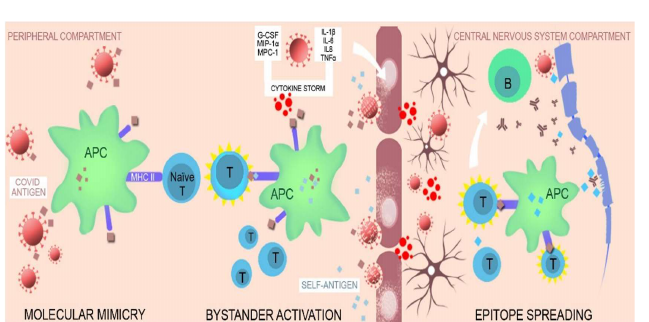
Figure 5. Graphical representation of the proposed mechanisms for viral induced autoimmunity. Key mechanism for viral induced autoimmunity: 1) molecular mimicry -cross-reactive response against virus and self-antigens leading to lymphocyte activation; 2) bystander activation - the released self-antigens are taken by the antigen presenting cells(APC) and presented to naïve T cells which become responsive. Simultaneously, the innate immune system triggers the production of proinflammatory cytokines and chemokines and initiate self-tissue destruction that generate self-tissue antigens mimicking viral antigens; 3) epitope spreading -the viral infection produce futher damage and release of more self-antigens with subsequent activation of auto- reative T cells. When the damage involves the central nervous system it triggers T and B cells activation and maintain a pro-inflammatory environment. In COVID-19, the chemotactic call of lymphocytes towards the lung tissue together with increased apoptosis in peripheral blood and bone marrow shut down leads to transient lymphopenia and immunosuppression with a loss of tolerance to some self- antigens [65]. This redistribution of immune cells also affects the innate components of immunity, such as dendritic cells, monocytes, and macrophages, that have the role of permanently scanning the tissues to identify non-self-structures against which an inflammatory response would be triggered while not reacting towards self-structures [152]. Damage to immune system components, immune system redistribution, and aberrant immune reconstitution during the recovery phase after viral resolution when the lymphocytes level increase again in the context of deviated immune reconstruction may lead to unregulated response with failure or poor recognition of some self-antigens with a triggering of autoimmunity phenomena in the context of immunodeficiency that affects both innate and acquired immunity [65]. Even thrombotic phenomena have been associated with the presence of antiphospholipid antibodies and may occur in the context of an antiphospholipid syndrome [153]. The risk of developing autoimmunity phenomena is probably related to genetic predisposition, especially the human leucocytes antigens (HLA) gene polymorphisms and other genes [154], the existence of autoimmune diseases in the family, and the preexistence of some autoantibodies such as antinuclear antibodies [65,155,156]. Due to the association between coronavirus infection and autoimmunity and the similarity of SARS-CoV-2 with these viruses, it is reasonable to assume that a link exists between SARS-CoV-2 infection and some later diagnosed autoimmune diseases [115]. Elevated levels of autoantibodies, such as antinuclear antigen (ANA) antibodies, anti-60- kDa and anti-52kDa SSA/Ro antibodies and antiphospholipid antibodies (aPLs), have been evidenced, especially in patients who have experienced severe forms of COVID-19 [115,157]. In addition to these antibodies known to be associated with autoimmune diseases, other antibodies such as autoantibodies against type I-IFNs or directed against other cytokines including GM-CSF, IL-6, and IL-10 have also been identified. In patients with neurological symptoms associated with severe COVID-19 cases, autoantibodies in serum and sometimes in CSF of neuronal targets have been identified (anti Yo antibodies, anti-NMDA receptor antibodies, and anti-myelin antibodies) suggesting a dysregulation